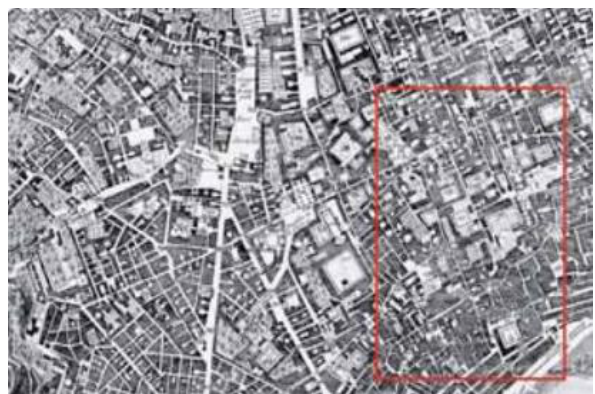
Figure 4. Duca di Noja. Map of Naples 1775